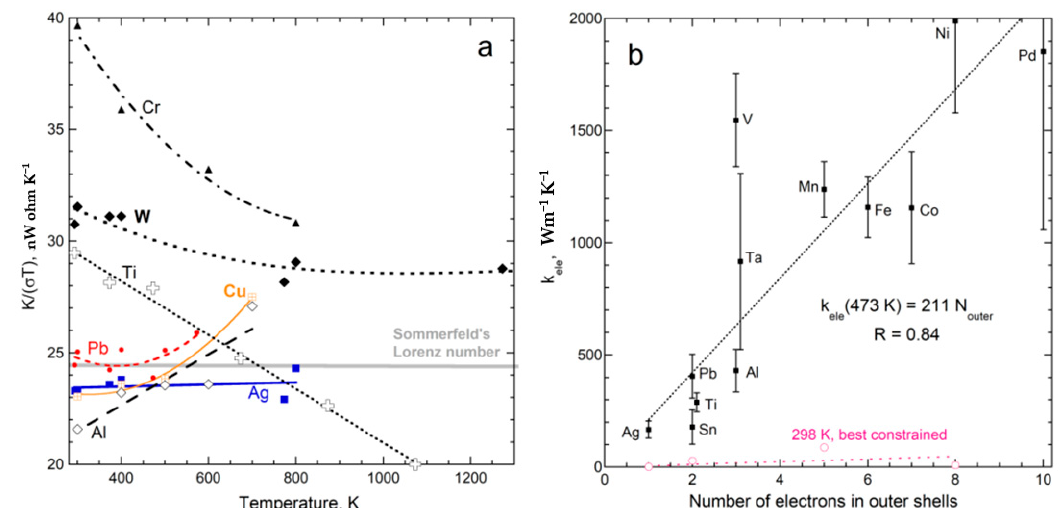
Figure 6. Data on metals: ( a ) Non-adherence to the Wiedemann–Franz law. Grey = Sommerfeld’s Lorenz number for the ratio of measured κ to electrical conductivity ( σ ) times T , is low by a factor of 3, stemming from ETKG describing fluctuations, not heat flow down a thermal gradient [6]. Black symbols and curves = data on 7 elements from [45] (Table 14.2). These elements had at least 4 temperatures where κ and σ were independently measured. ( b ) Correlation of κ ele (obtained from measured D and electronic heat capacity) with the number of nearly free electrons. Part ( b ) is modified after Figure 20b in Criss and Hofmeister [9], which is open access.